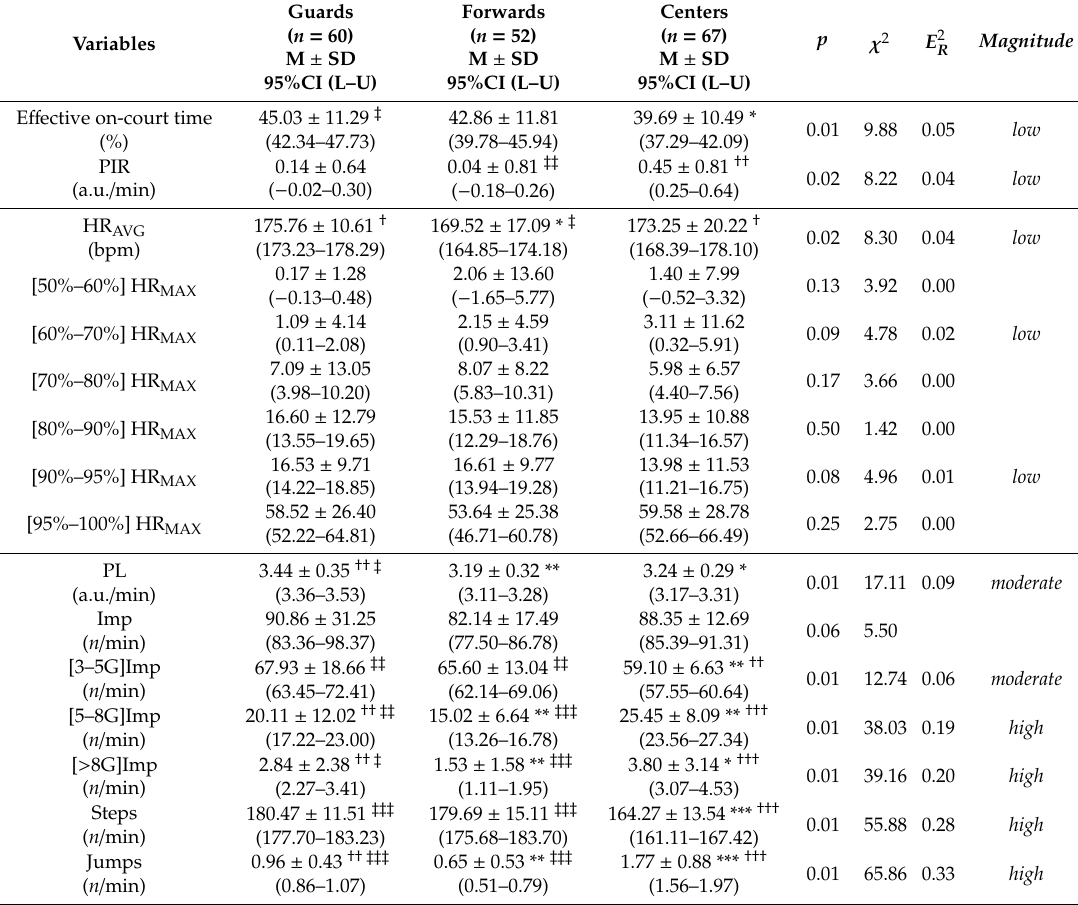
Table 1. Descriptive and inferential analysis of the analyzed variables as a function of playing